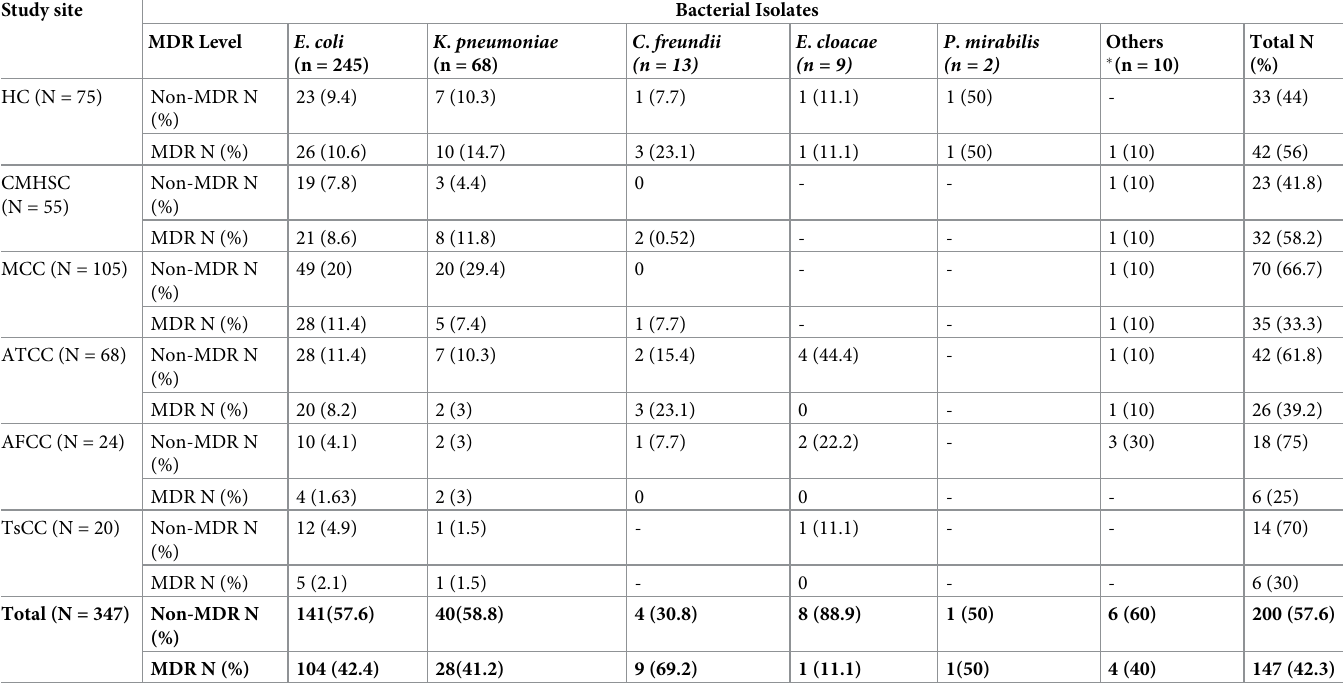
Table 4. Distribution of MDR-E isolates from the six cafeterias, among food handlers at the University of Gondar Comprehensive Specialized Hospital and Stu- dents’ Cafeteria, Northwest Ethiopia, February to June 2021. Study site Bacterial